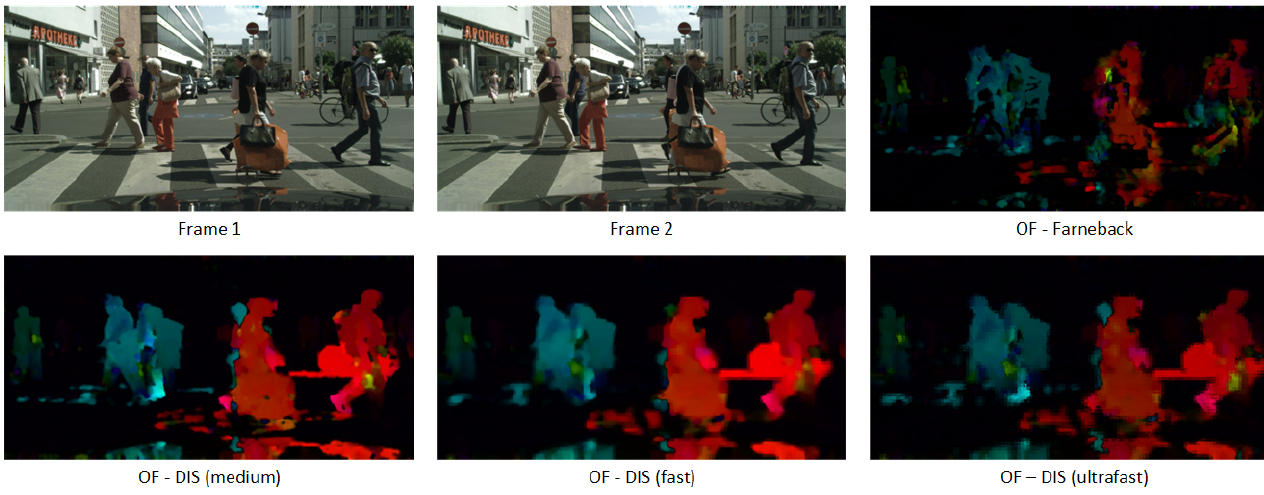
Figure 6. Optical Flow